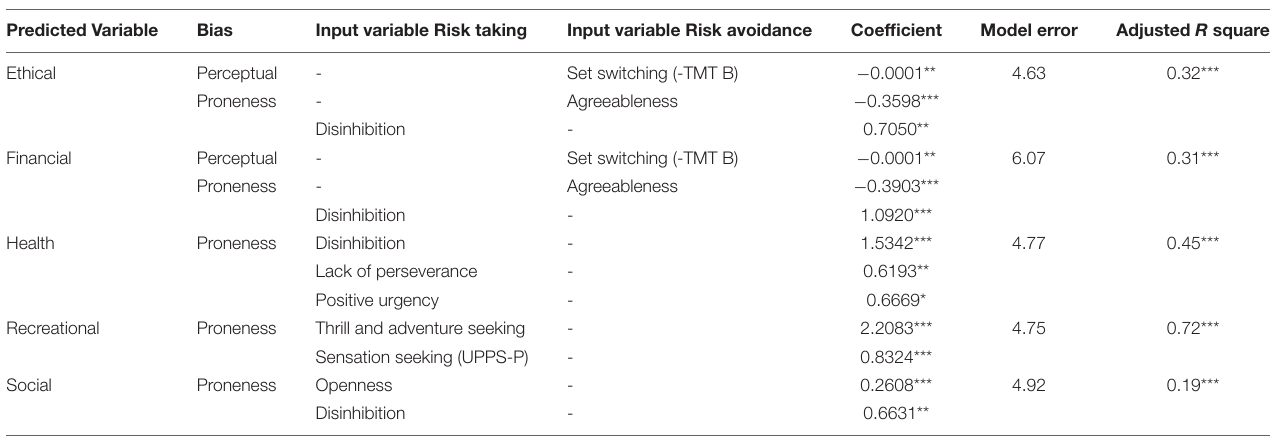
FIGURE 2 | Correlation matrix obtained by Pearson coefficients between every pair of variables and the range of statistical significance by correlation. ∗ p < 0.05, ∗∗ p < 0.01, and ∗∗∗ p < 0.001. Pearson coefficient of 0.285 achieves a power above 80%. TABLE 2 | Statistical table showing the multilinear regressions for all output